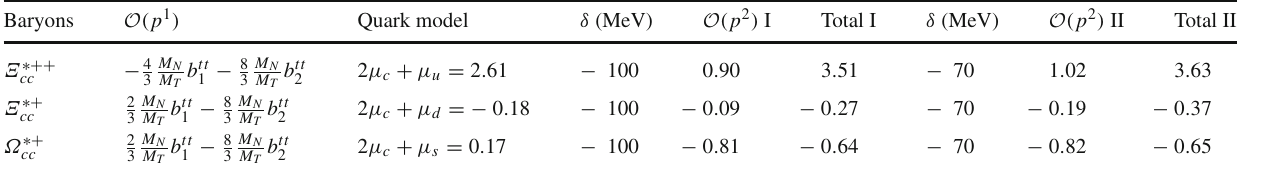
unit of μ N ). The magnetic moments in the third column are evaluated by quark model, which are treated as the O ( p 1 ) magnetic moments. We adopt δ = − 100 MeV and δ = − 70 MeV as two parameter sets